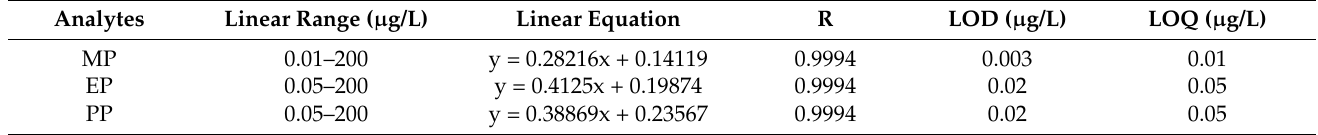
Table 4. Linear equation, lower limit of detection, and lower limit of quantification of the method.